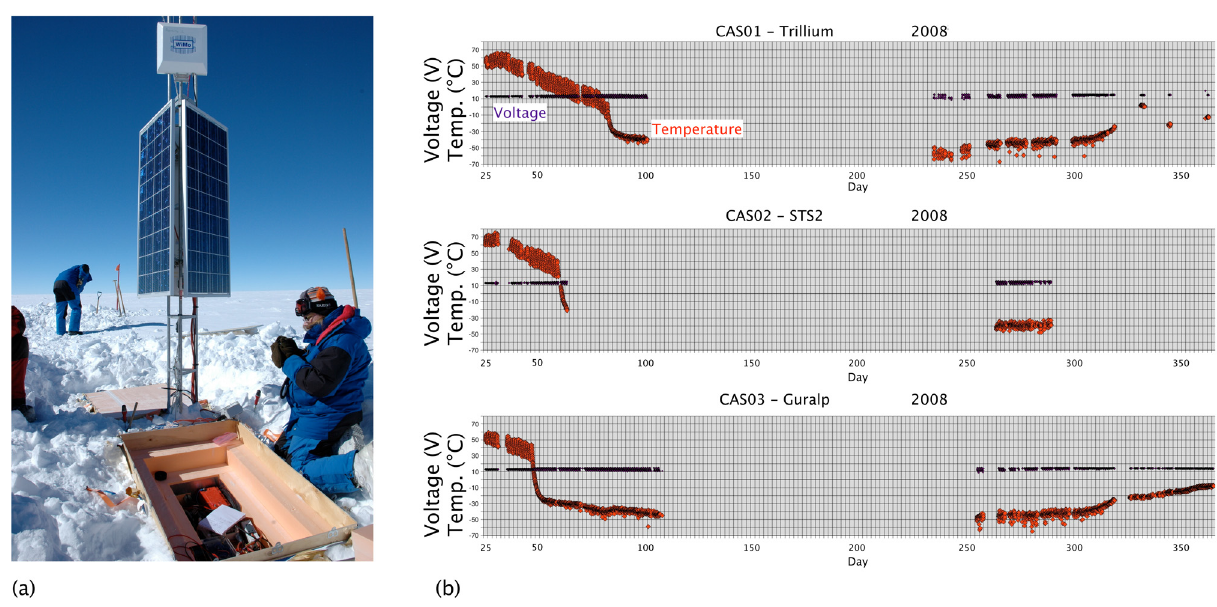
Figure 4. Tests of the prototype CASE stations. (a) Field deployment (the acquisition box is open, the battery box is visible behind the mast, and the position of the buried seismometer is indicated by the flag in the background. (b) Radio transmitted SOH (state of health) information for 2008 for the three stations CAS01, CAS02, CAS03 with three different seismometers (quoted after the station code), showing that the stations shut down in winter and power up again in spring: temperature of the acquisition box as measured by the RT-130 (red), battery voltage (blue). The sharp drop in temperature occurs when there is insufficient solar energy to power the heating.